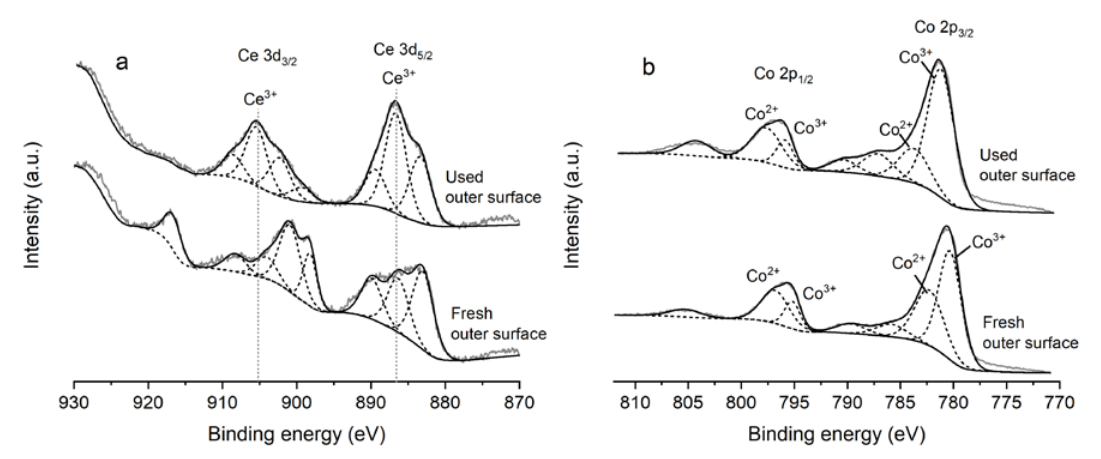
Figure 12. The XPS spectra of fresh and 16 h CoAlCe-P; ( a ) Ce 3d and ( b ) Co 2p.